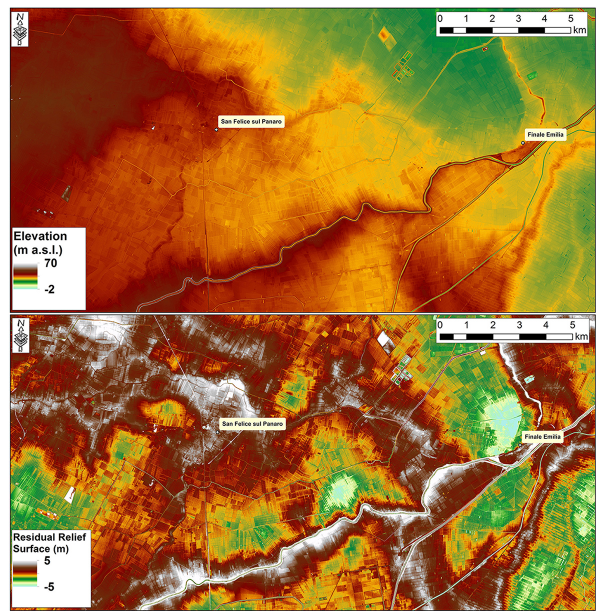
Figure 4. Comparison between the original 1m lidar DTM (upper panel) and the residual relief surface (RRS – lower panel). The cal- culation of the RRS emphasizes rising and depressed landforms and makes easier their comparison at different locations, independently from the regional trend of the